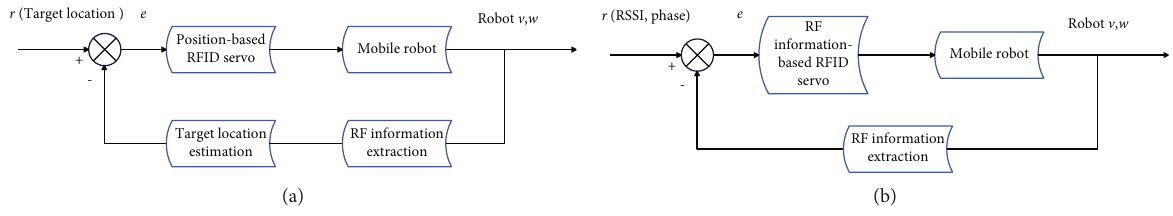
Figure 7: Mobile robot navigation based on RFID servo. (a) Position-based RFID servo. (b) RF information-based RFID servo.